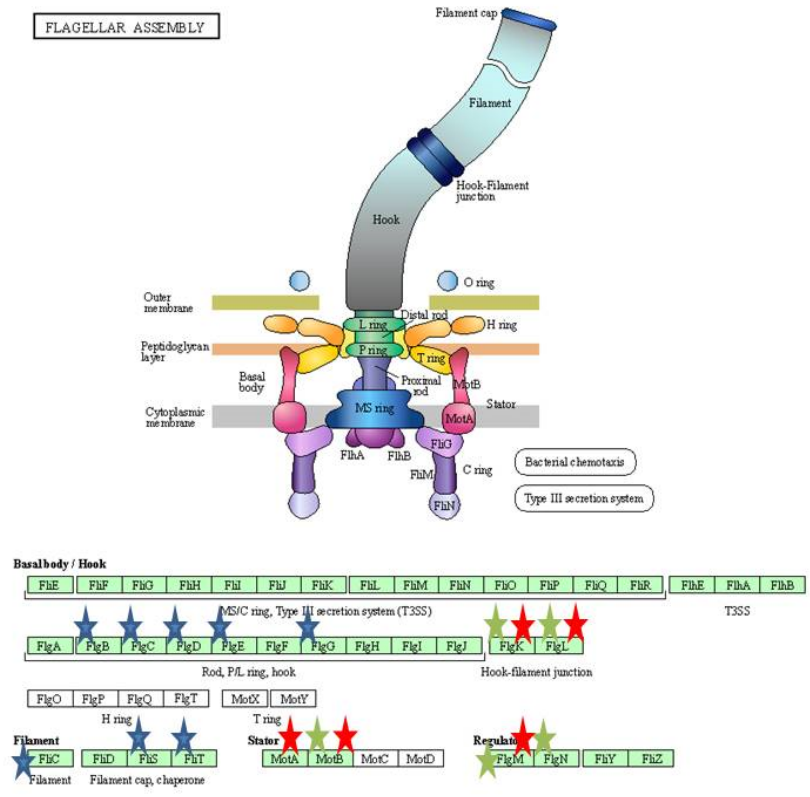
Figure 9. Flagellar pathway assembly (KEGG database). Blue stars represent the downregulated genes in bile and bile antibiotic treatment, green stars represent the genes downregulated in only bile treatment. Red stars represent the upregulated genes (B vs.